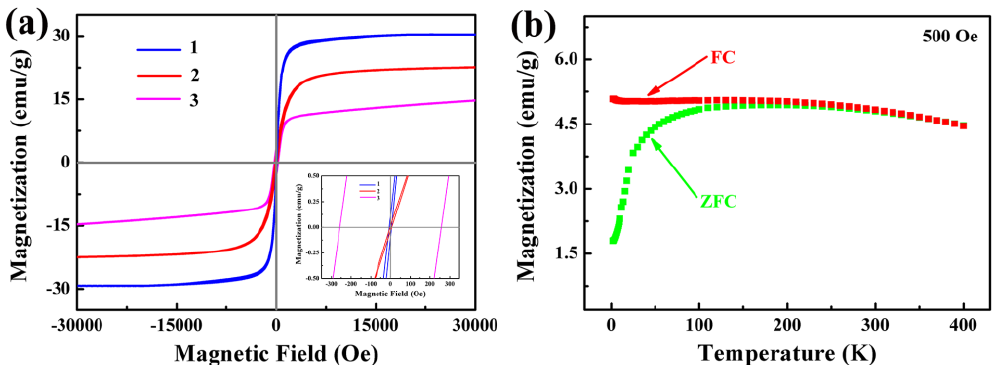
Figure 6. ( a ) Hysteresis curves recorded of Fe 3 O 4 /Ag nanoparticles at 300 K (curve 1), Fe 3 O 4 /Ag/POMs nanocomposites at 300 K (curve 2) and 5 K (curve 3) (Inset: Field response around the origin), and ( b ) ZFC-FC curves of Fe 3 O 4 /Ag/POMs nanocomposites under a magnetic field of 500 Oe.